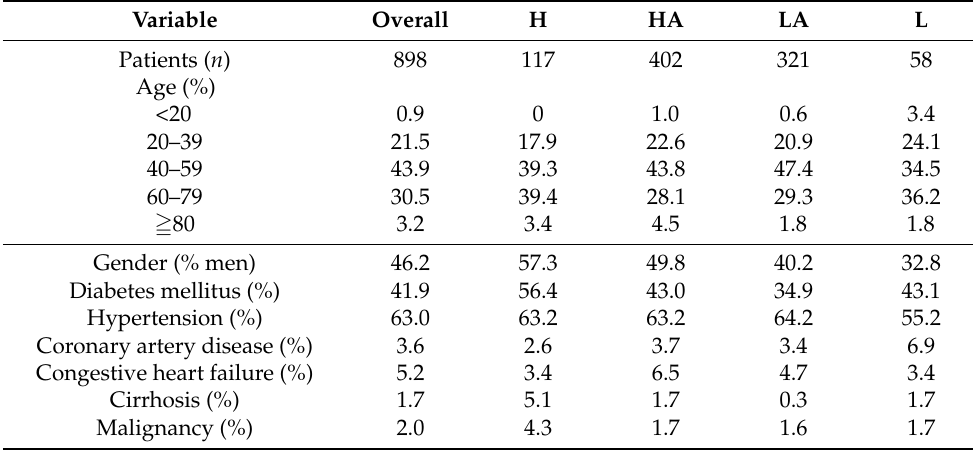
Figure 1. Flow chart of the study cohort. Abbreviations: PD—peritoneal dialysis; HD—hemodialysis. Table 1. Demographics and clinical variables, according to PET